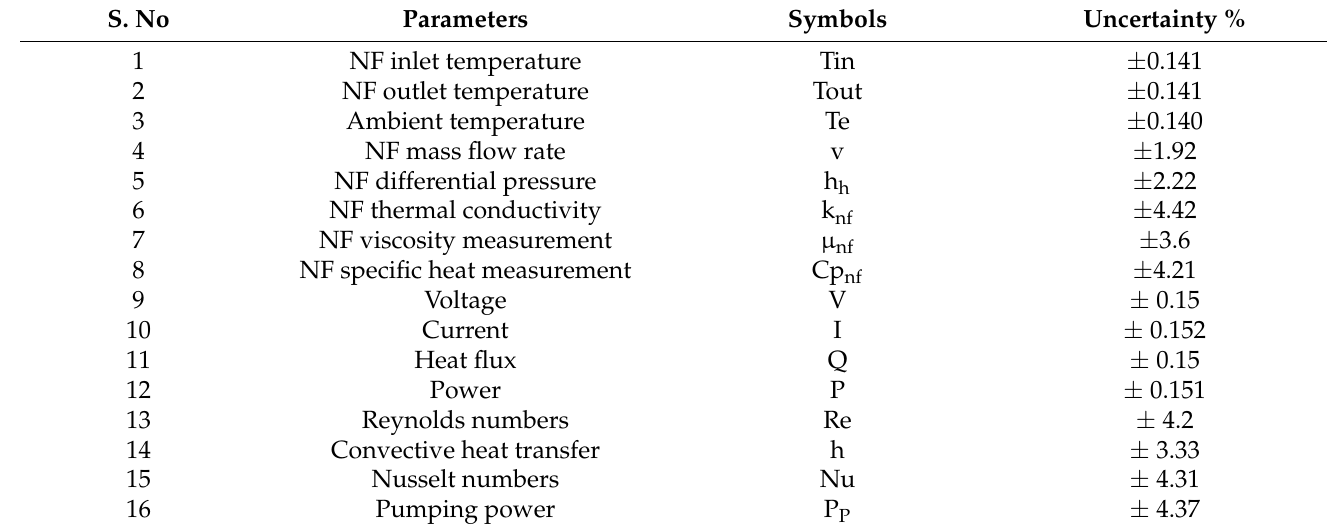
Table 2. Uncertainties of varying parameters of the experimental test